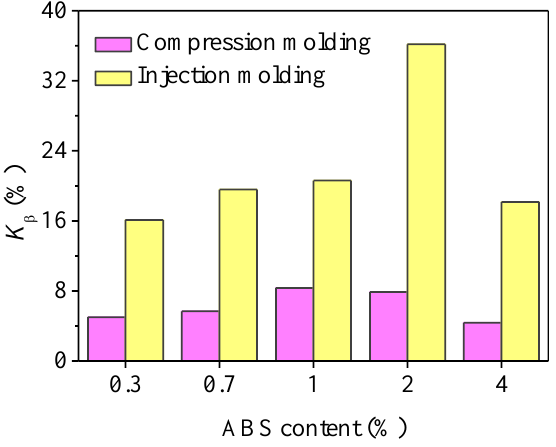
Figure 7. Relative content of β-crystal ( K β ) for the blends with respect to ABS content.